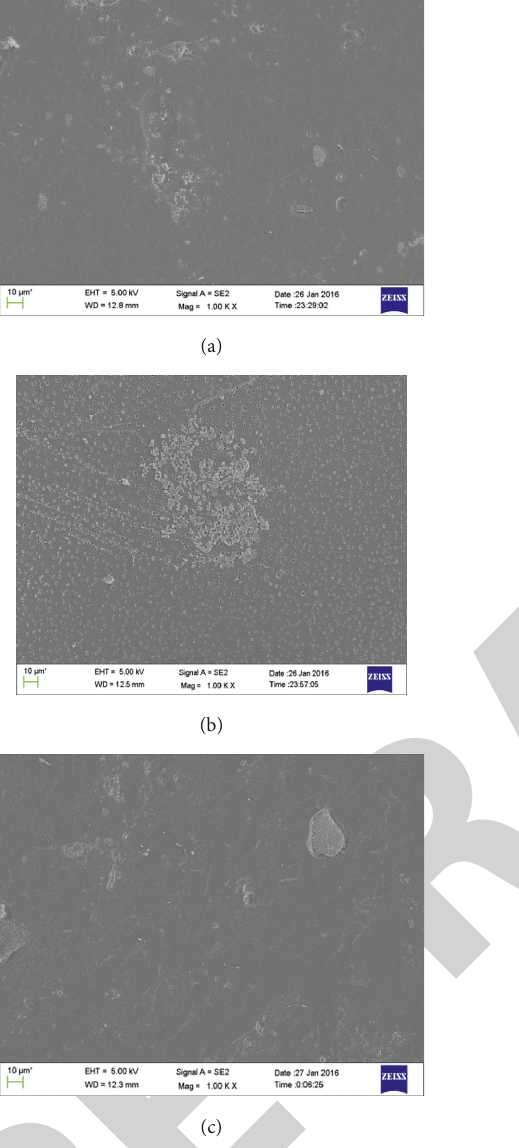
Figure 4: SEM images of polymer electrolyte films for different PVP/PVA : GO wt.% ratios of (a) (0.20 : 0.1), (b) (0.25 : 0.2), and (c) (0.30 : 0.3).